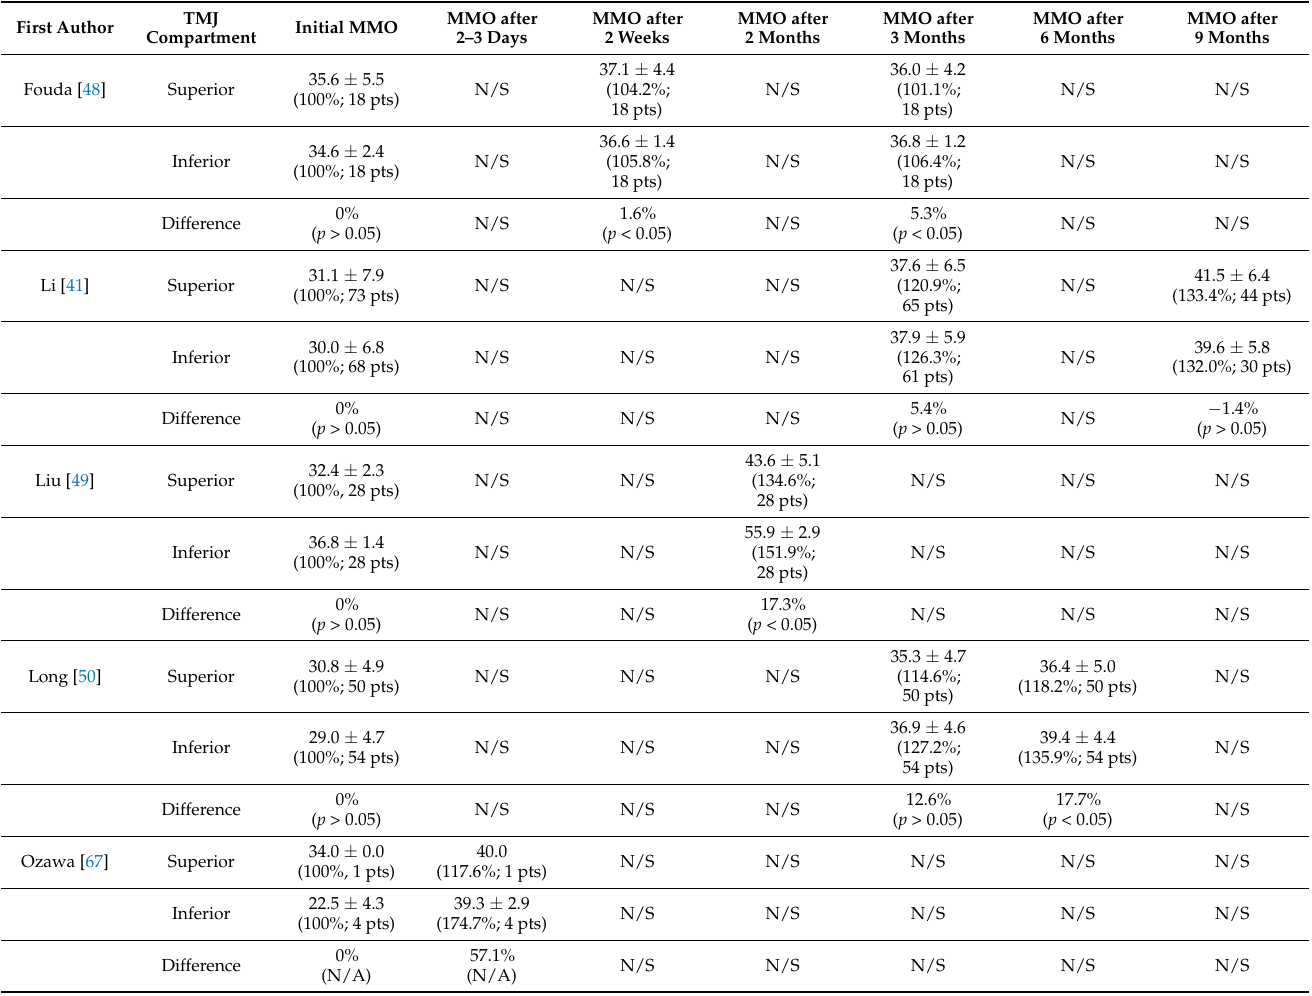
Table 6. Maximum mouth